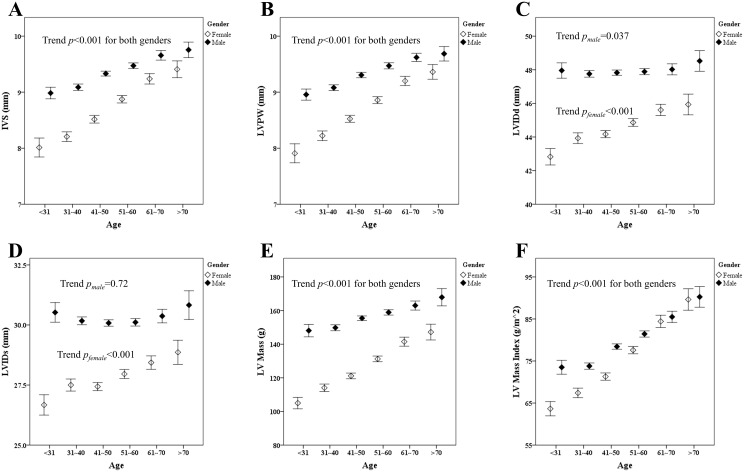
The means of interventricular septum (1A), left ventricle posterior wall (1B), left ventricle internal diameter end diastole (1C), left ventricle internal diameter end systole (1D), left ventricle mass (1E), and left ventricle mass index (1F) of different gender and age groups.The number of subjects in different age groups was 141, 464, 931, 1020, 515 and 201 for the following age groups: <30, 31~40, 41~50, 51~60, 61~70 and >71 (years) for female; and 253, 1011, 1724, 1430, 515, 205 for male as same age categories, respectively. All p values for trends are shown in the figure.